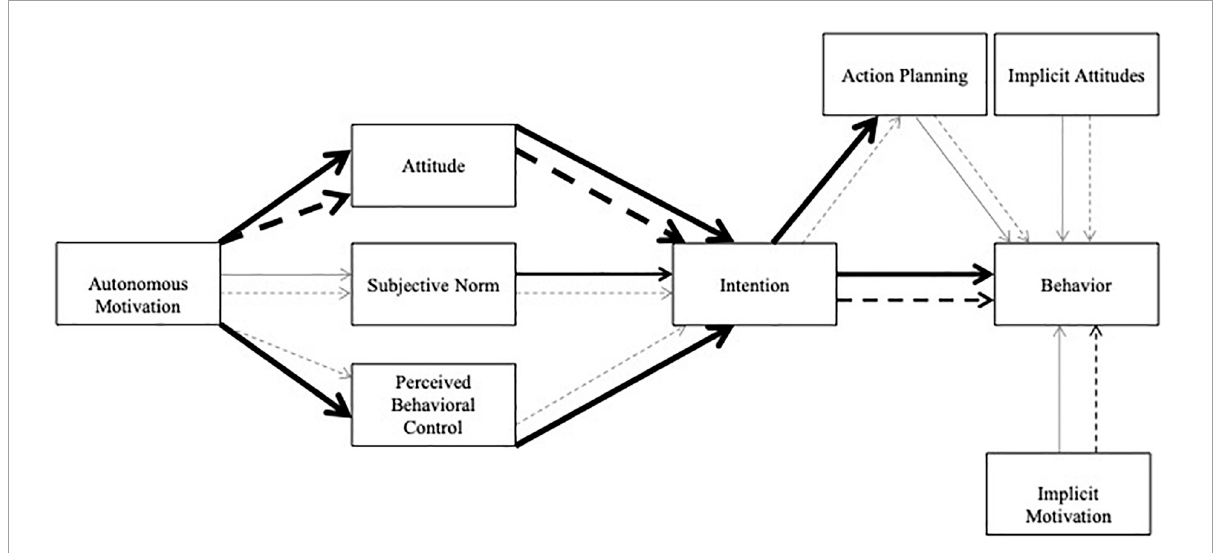
FIGURE2 Supported paths across multiverse analysis for the Integrated Behavior Change Model weighted by level of support. Initiators are represented by the solid lines only. Maintainers are represented by dashed lines only. Thicker lines indicate support across more multiverse iterations than thinner